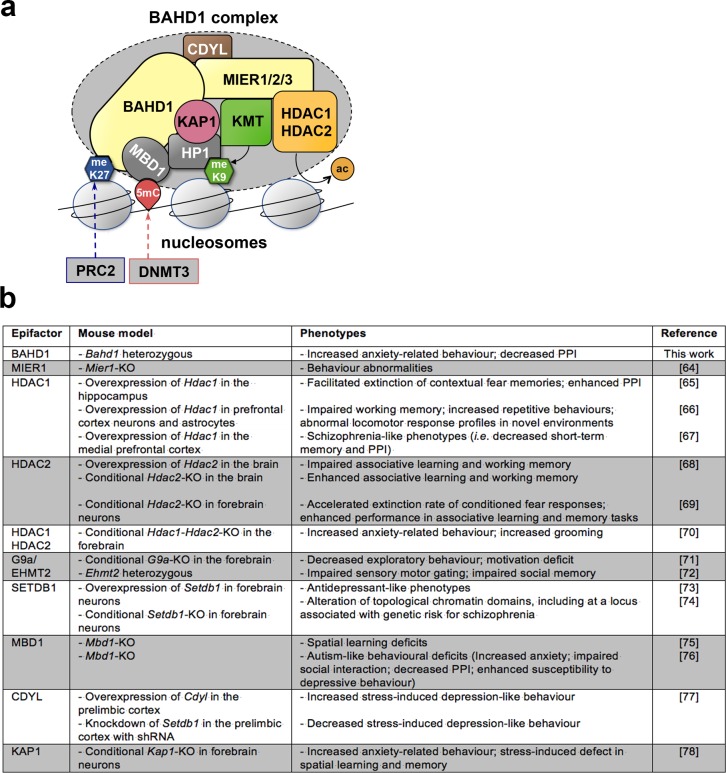
Relationship between the components of the BAHD1 chromatin-repressive complex and neurological disorders.(a) Schematic representation of the BAHD1 chromatin-repressive complex (KMT: histone lysine methyltransferase; meK9: histone H3 methylated at lysine 9; PRC2: Polycomb repressive complex 2; meK27: histone H3 methylated at lysine 27; DNMT3: DNA methyltransferase 3; 5mC: 5-methylcytosine; ac: removal of acetyl groups on histones by HDAC) (adapted from [6]). (b) Behavior-associated phenotypes in mice observed upon deficiency or overexpression of BAHD1-associated molecular partners and the references [59–73] for the relevant studies.